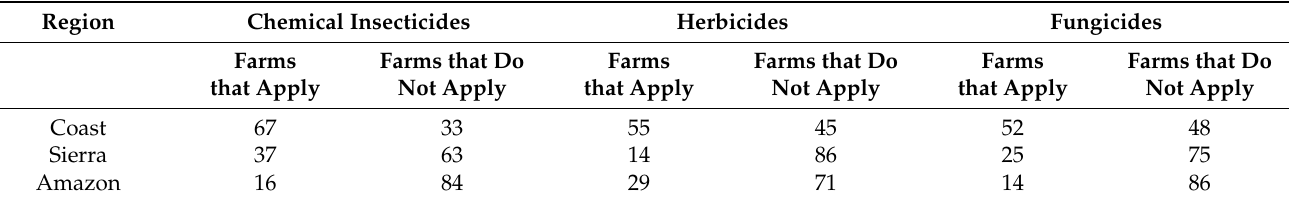
Table 2. Percentage of pesticide use by every 100 farms in each region of Peru.